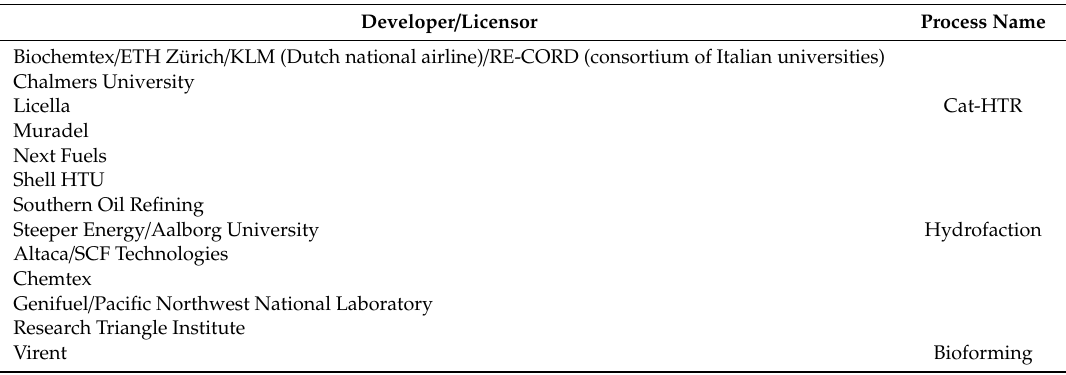
Table 8. Developers / licensors of relevant liquid conversion and synthesis